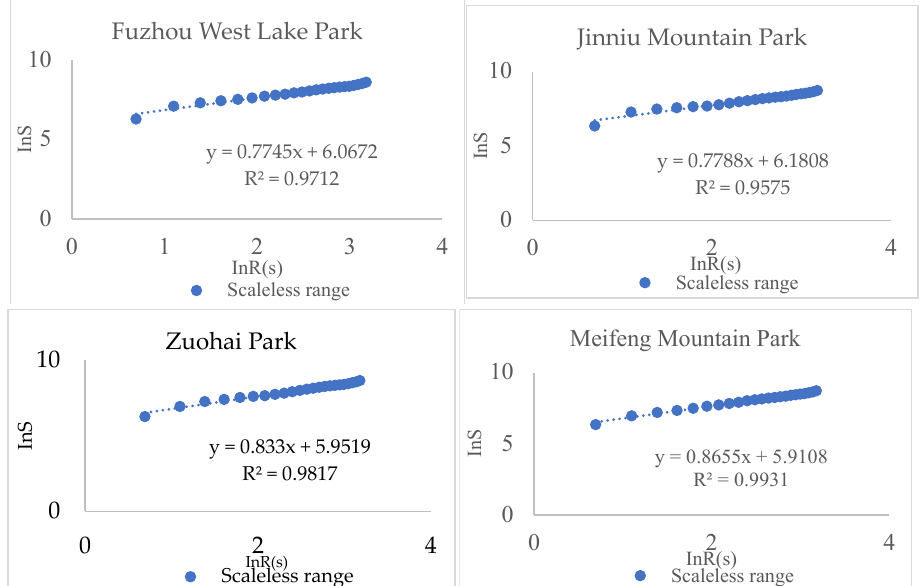
Table 1. The determining data of fractal dimension of Fuzhou’s park system.